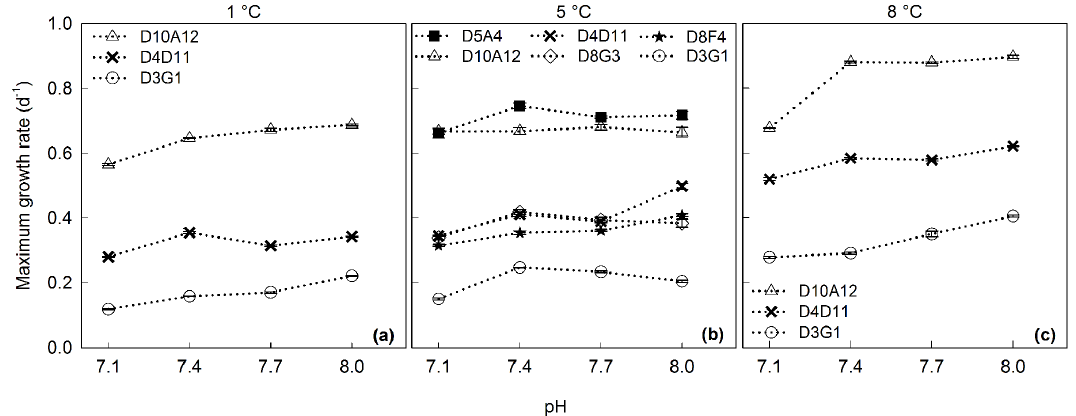
Figure 2. The mean maximum growth rates (d − 1 ) of strains D5A4, D10A12, D4D11, D8G3, D8F4 and D3G1 cultivated at (a) 1 ◦ C, (b) 5 ◦ C and (c) 8 ◦ C, and all four pH treatments. Error bars represent ± SD. Note that the data are categorical and the dotted lines serve to show the